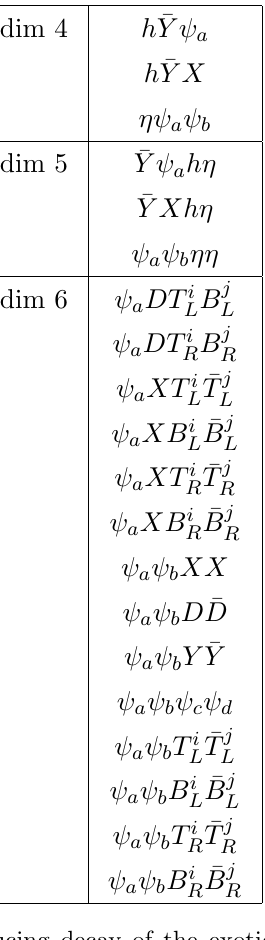
Table 8 . Leading interactions producing decay of the exotic fermions. Here, the superscript i refers to unprimed, primed, or double primed for the three generations of top and bottom quarks, and the subscript a ranges over 1 ; 2 ; 3 for the three neutral